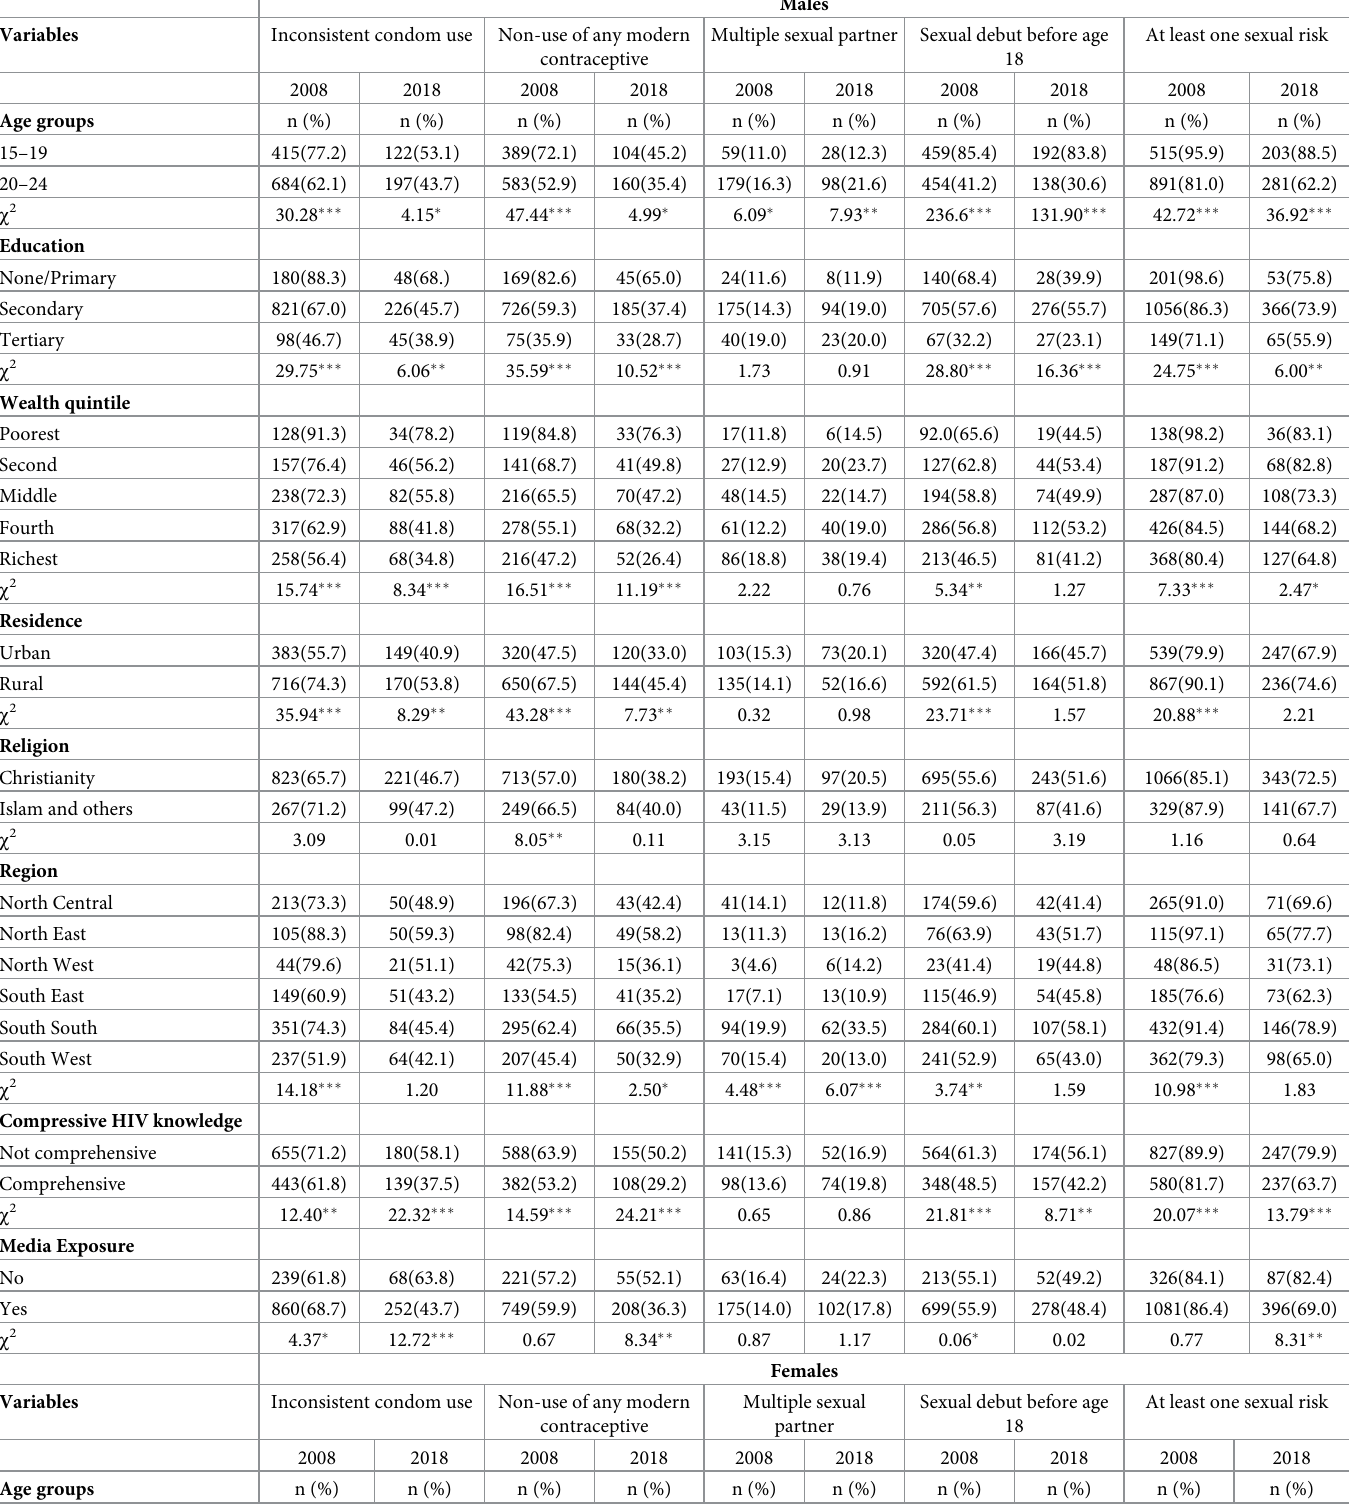
Table 4. Factors associated with contraceptive and sexual behaviour of young people in Nigeria using 2008 and 2018